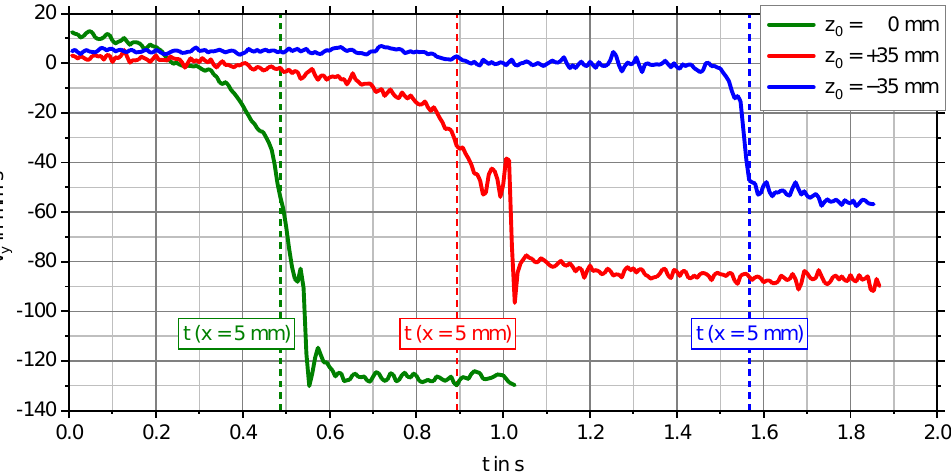
Figure 11. Tracer particles in different measuring planes z 0 while passing and past the weir: the vertical velocity component v y is plotted over time t . When the liquid foam ( c 1 = 1.0gL − 1 ) flowed into the open surrounding ( x > 5mm), accelerated by gravity, the tracer particle in the central plane ( z 0 = 0mm) reached a higher terminal velocity than those closer to the left ( z 0 = + 35mm) or right side wall of the flow channel ( z 0 = − 35mm). This is exemplarily shown for three tracer